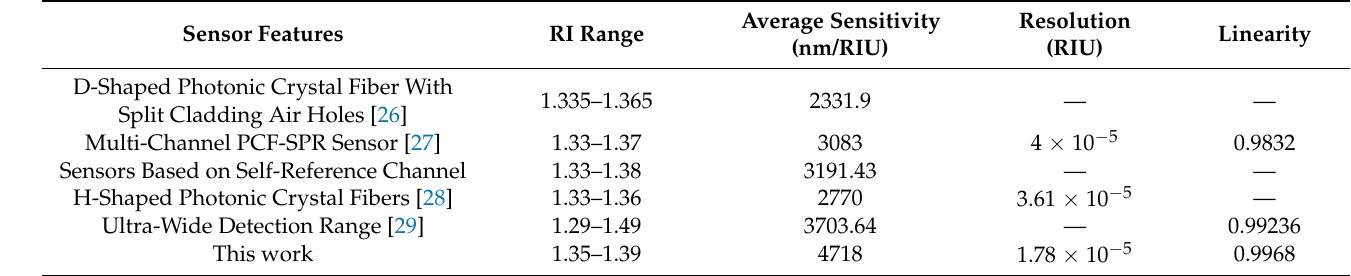
Table 1. Comparison of Various Fiber ‐ SPR Sensor Performances.